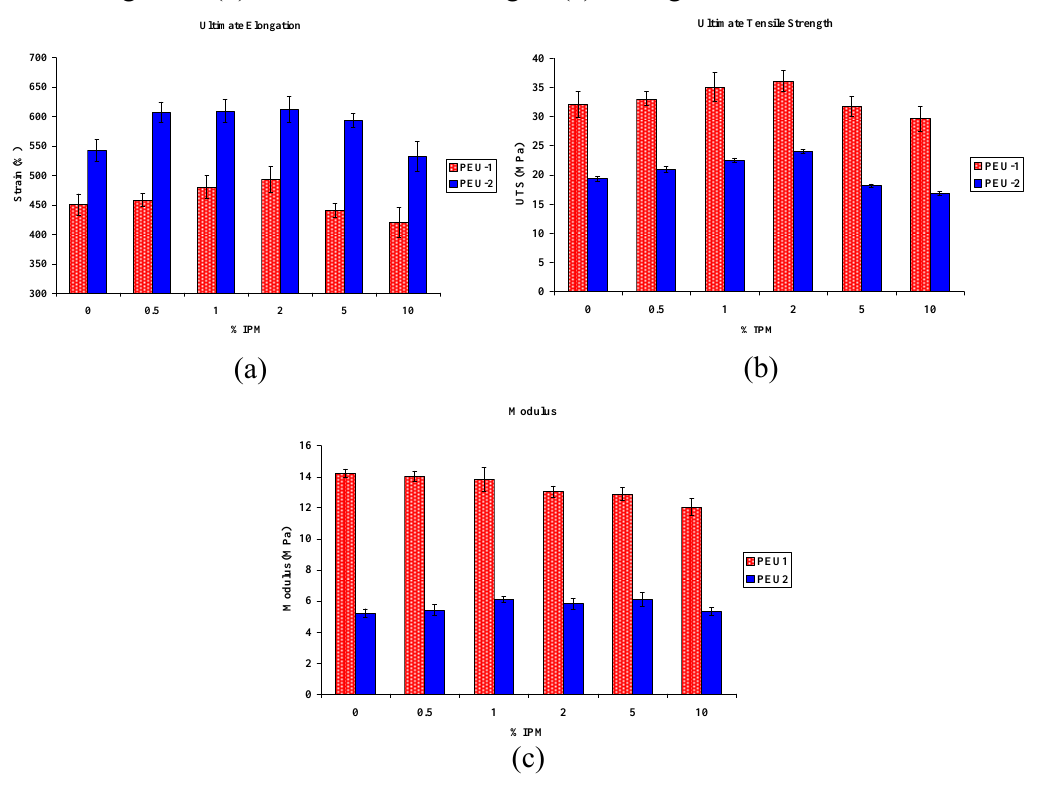
Figure 6. Effect of IPM content on mechanical properties of polyether urethanes (a) ultimate elongation; (b) ultimate tensile strength; (c) Young’s